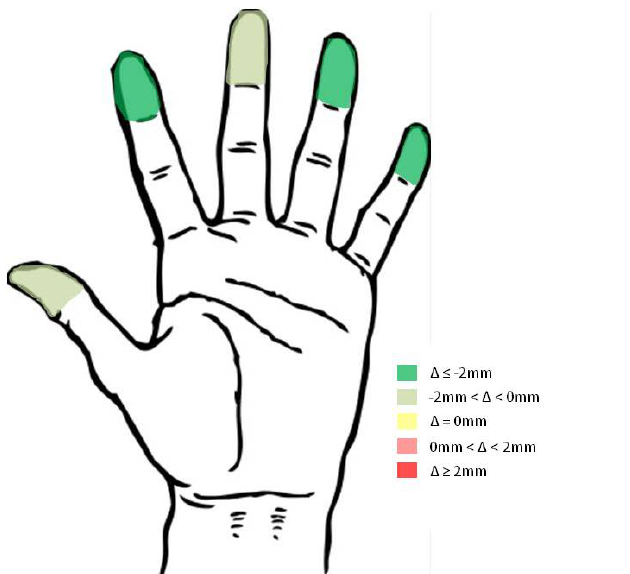
Fig. 12. Graphical depiction of 2-point discriminator test results “with glove.”